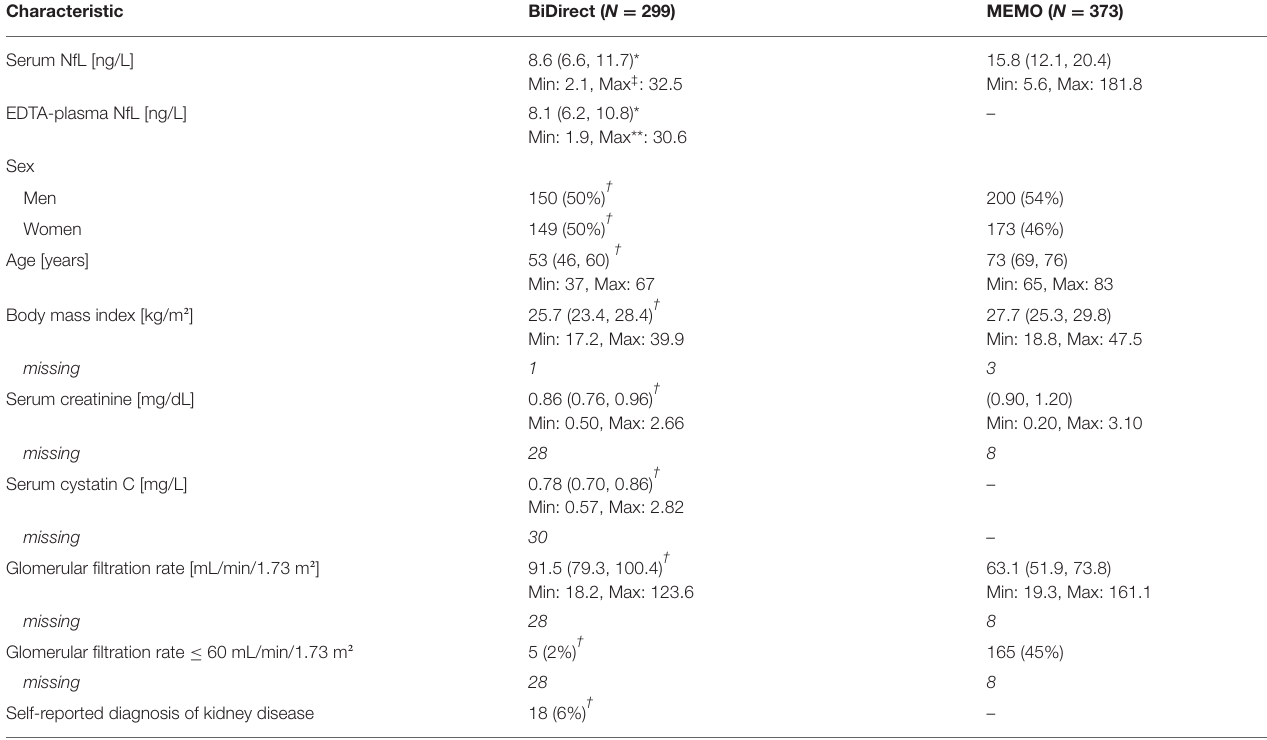
TABLE 1 | Sample characteristics in the BiDirect and MEMO studies. Characteristic BiDirect ( N =